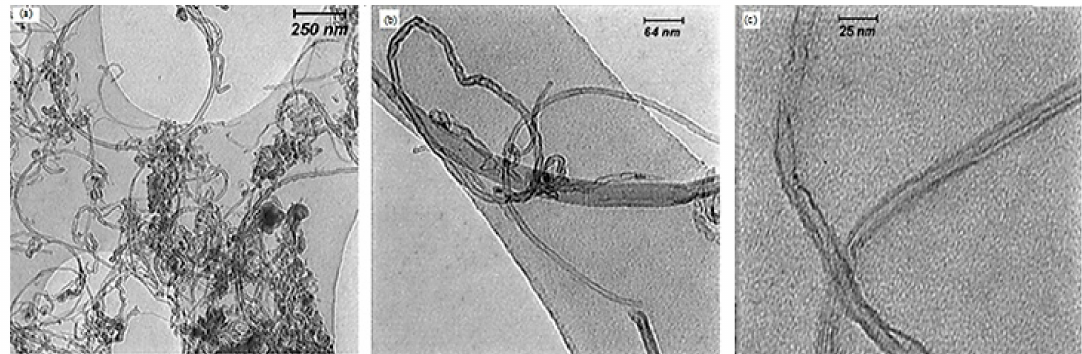
Figure 8. TEM images of as-prepared CNTs ( a ) catalyst concentration = 3 wt %, hydrogen flow = 240 cm 3 /min, and temperature = 900 ◦ C; ( b ) catalyst concentration = 4 wt %, hydrogen flow = 120 cm 3 /min, and temperature = 1000 ◦ C; ( c ) catalyst concentration = 5 wt %, hydrogen flow = 160 cm 3 /min, and temperature = 900 ◦ C, by using ultrasonic bath.